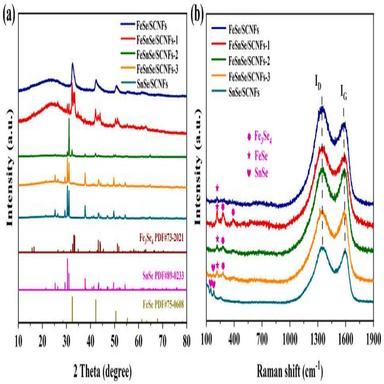
(a) XRD spectra and (b) Raman spectra of FeSe/SCNFs, FeSnSe/SCNFs-1, FeSnSe/SCNFs-2, FeSnSe/SCNFs-3 and SnSe/SCNFs.